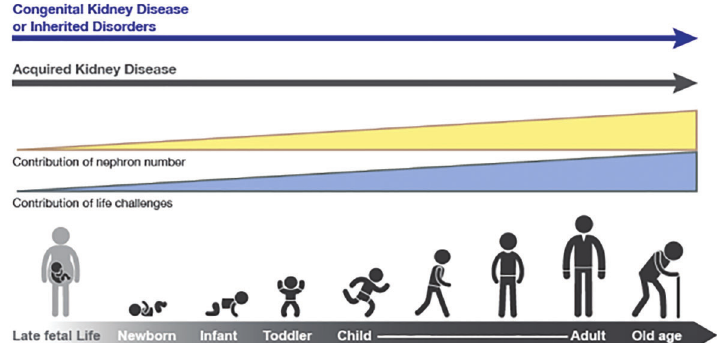
Figure 1. The types and risks of kidney disease change across the life cycle. The contribution of nephron number increases over the life cycle, in concert with events that provide direct insults and challenges to kidney